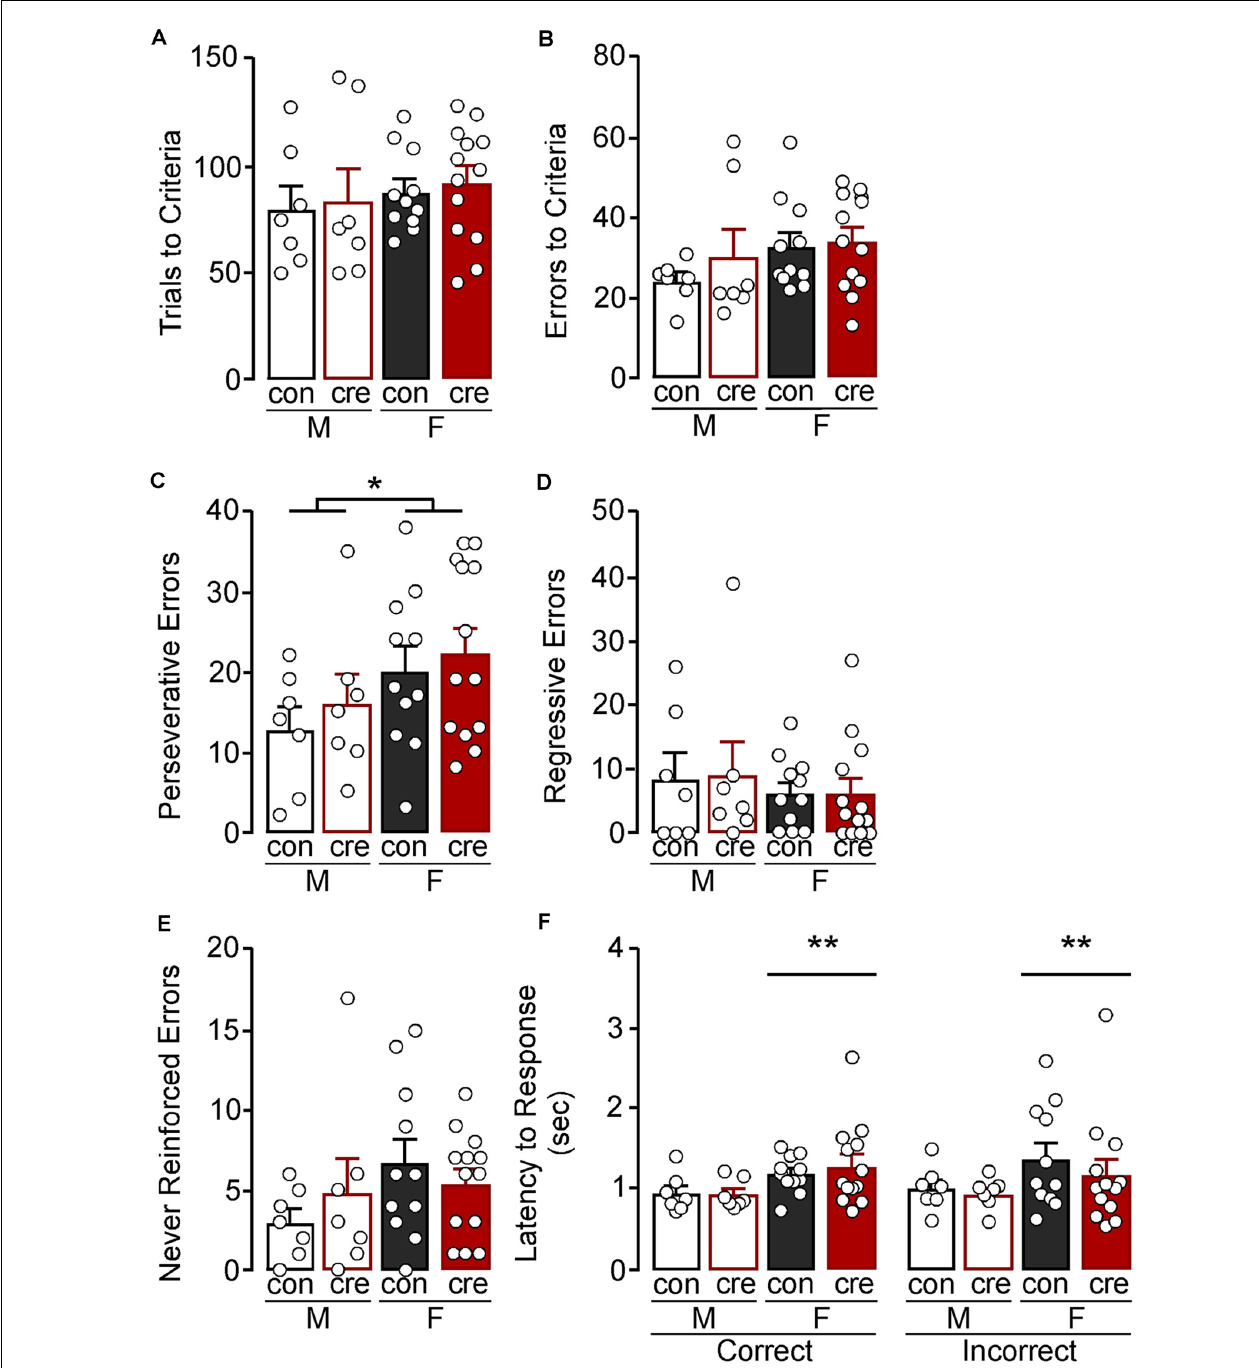
FIGURE 3 | Extradimensional shift test. (A) Trials criterion and (B) errors to criterion were similar for all groups. (C) Females made more perseverative errors compared to males (* p < 0.05) while the number of (D) regressive and (E) never reinforced errors were similar for all groups. (F) Females took longer to respond compared to males (** p < 0.01) regardless of condition and response type.